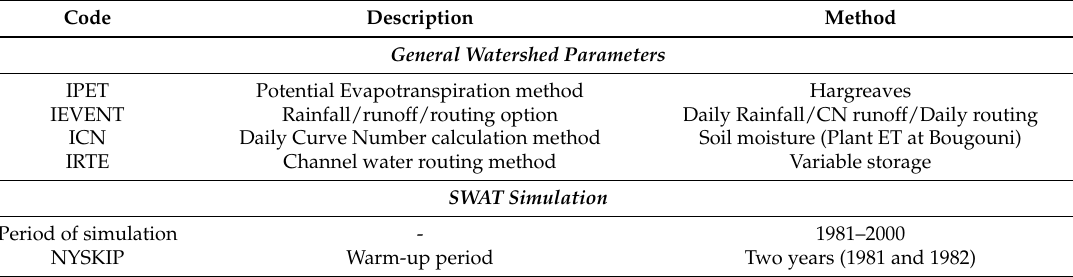
Table 2. Input methods for SWAT model simulation on the Bani